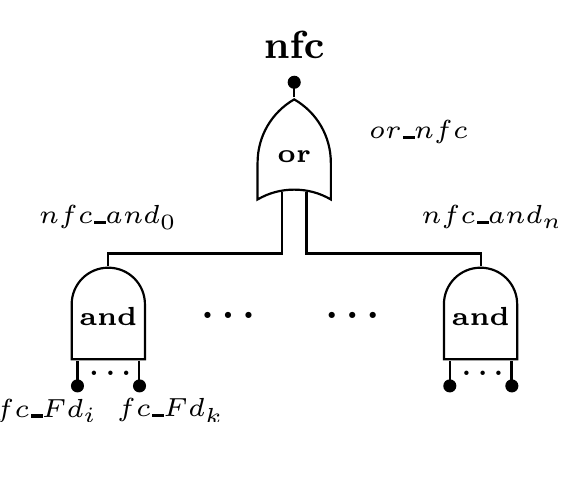
Figure 6. Network failure condition